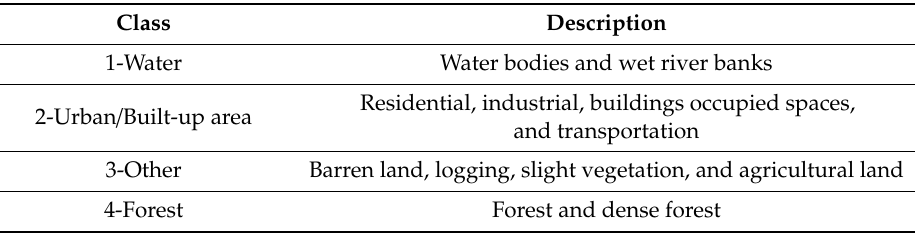
Table 1. Land-use / Land cover